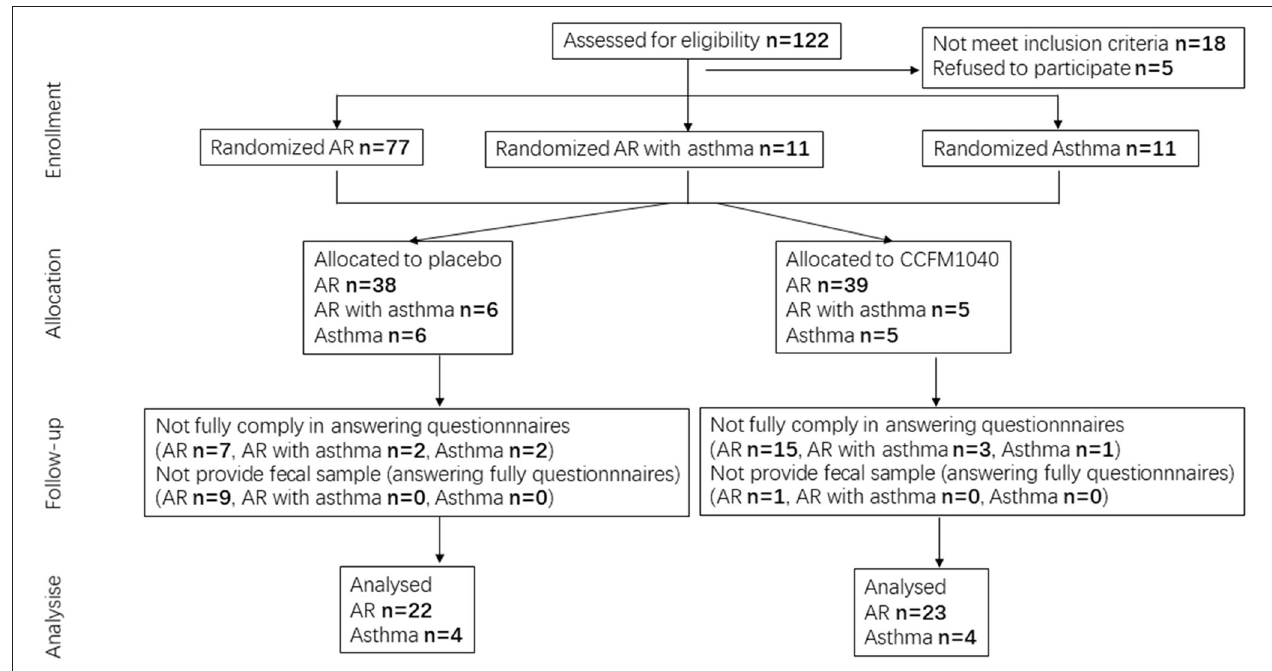
FIGURE 1 | Flowchart of the